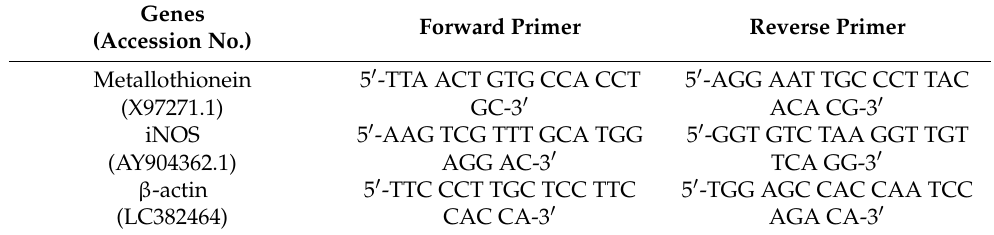
Table 1. Primers used for qPCR